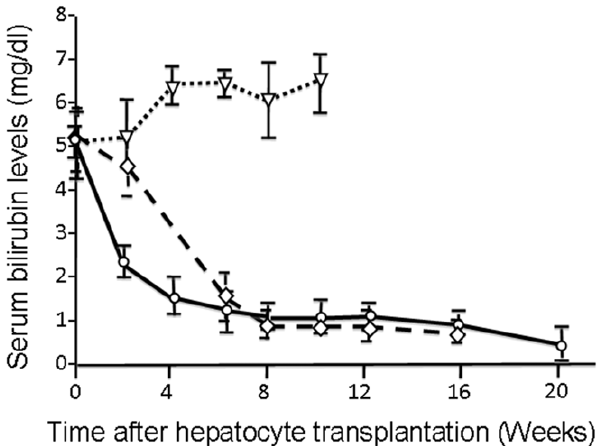
Figure 2. Conformal HIR followed by hepatocyte transplanta- tion ameliorates bilirubin levels in a hyperbilirubinemia model. The control group of Gunn rats received Ad-HGF followed by hepatocyte transplantation without HIR (triangles, n=4). One experi- mental group received Ad-HGF and preparative median lobe HIR (1/3 of liver, diamonds, n=6) before hepatocyte transplantation. Another experimental group received Ad-HGF and preparative HIR of the median plus left lobe (2/3 of liver, circles, n=8) before hepatocytes transplantation.